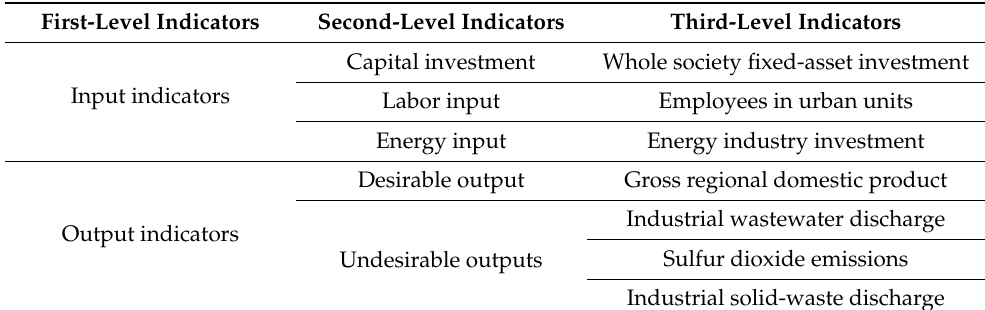
Table 1. Measurement system for green economic efficiency